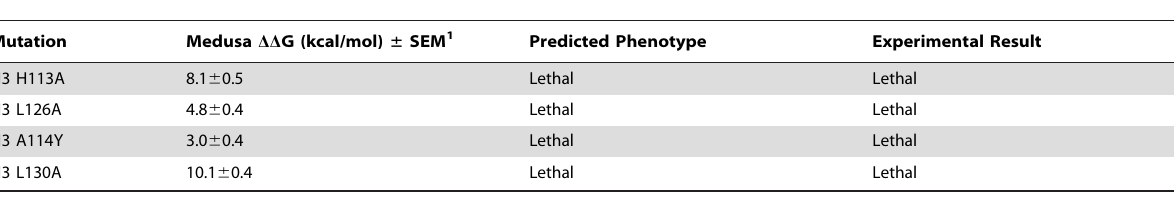
Table 1. List of mutations in H3 screened in this study.